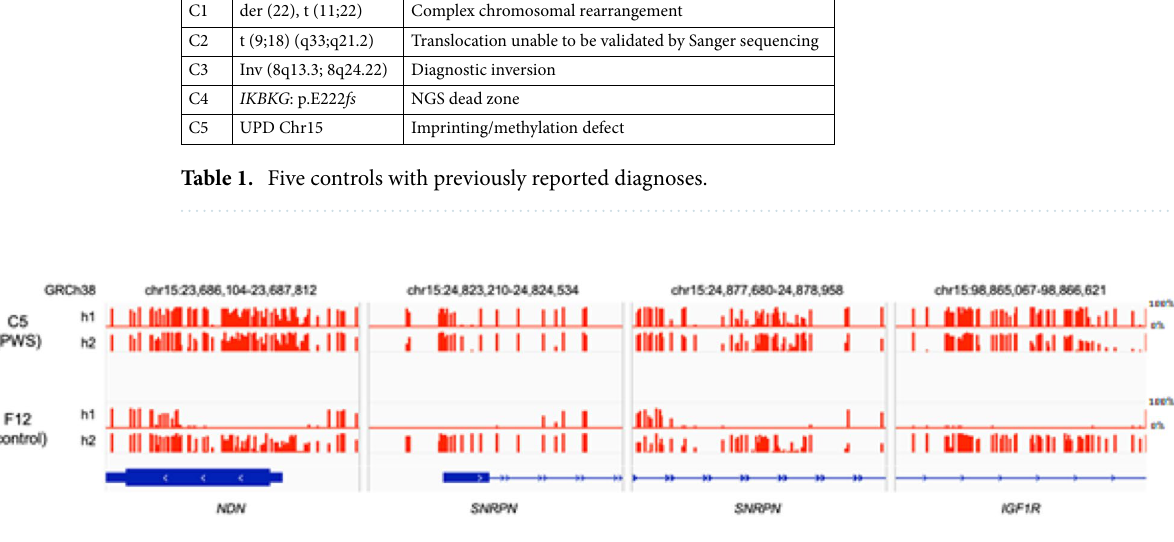
Figure 1. Biallelic hypermethylation on chr15 in Prader–Willi syndrome (PWS). Methylation analysis of HiFi reads shows hypermethylation of both haplotypes at known chr15 imprinted loci in a male patient, C5, with Prader–Willi Syndrome. An unrelated, unaffected male control, F12, shows hypomethylation of one allele. HiFi reads are phased by sequence into haplotype 1s and 2. Values show the percent of reads from each haplotype that are methylated at each genomic CpG site. h1 haplotype 1, h2 haplotype